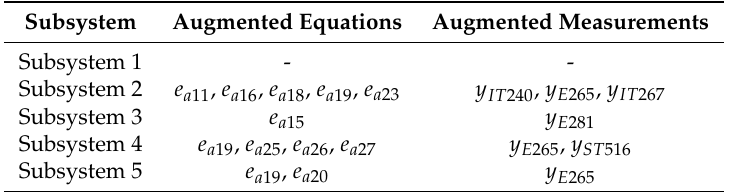
Table 5. Set of augmented equations and measurements for each subsystem model using the equation- based approach.